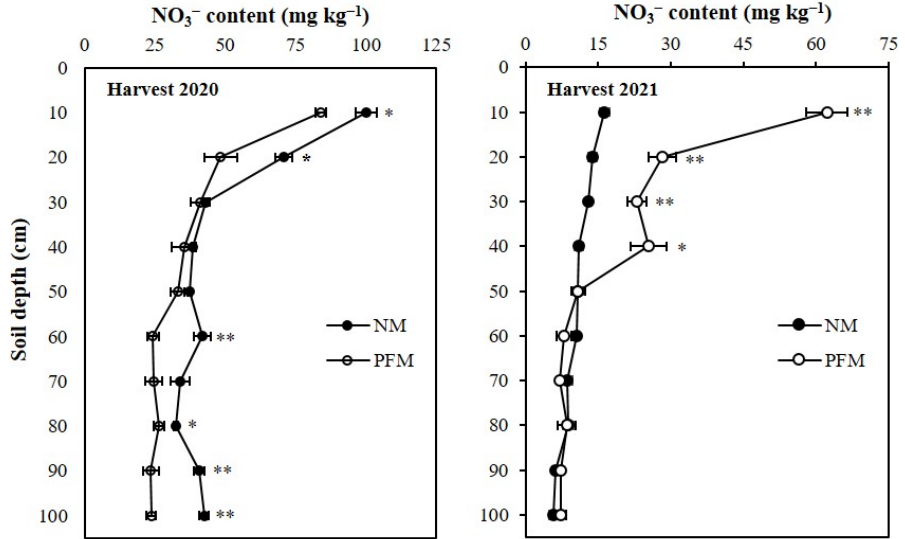
Figure 5. Effects of plastic film mulching and no-mulching treatments on the depth distribution of NO 3 − in the soil profile at final harvest of maize. ** Significant differences between treatments at p < 0.01, * significant differences between treatments at p < 0.05. 2020, soil sampling at final harvest in 2020; 2021, soil sampling at final harvest in 2021 PFM, plastic film mulching; NM, no-mulching (control).